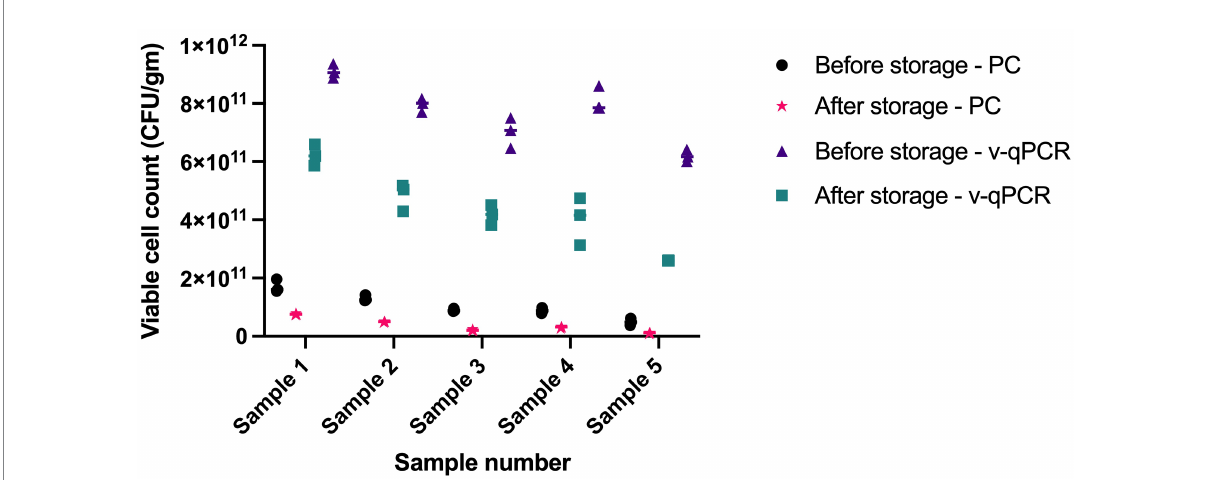
FIGURE 7 Assessing the ability of L. paracasei 8700:2 viability real-time PCR method to detect cell death following storage. Storage for 1 year resulted in 2.2-to-4.4-fold reduction in cell counts using plate count (PC) method and 1.5 to 2.4 fold reduction in cell counts using viability real-time PCR